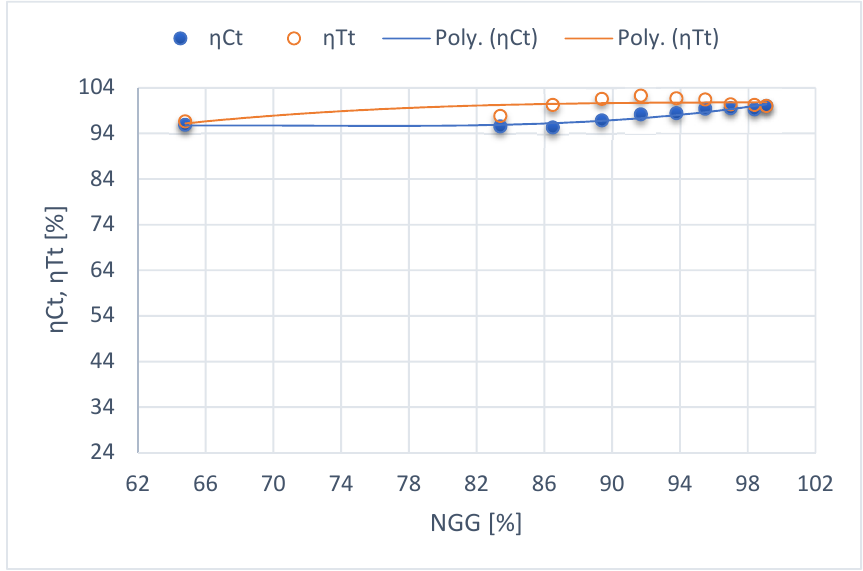
Figure 13. Compressor and turbine total adiabatic efficiency percentage variation.